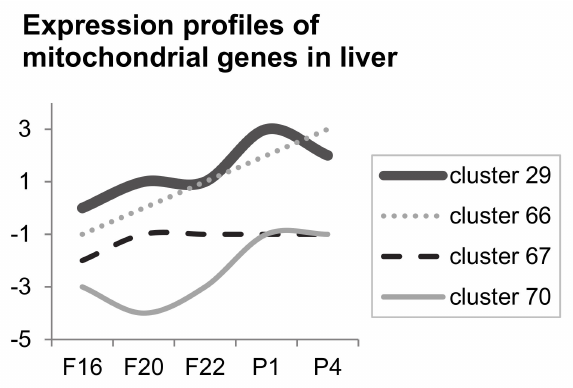
Figure 6. Four types of expression profiles significantly enriched in the rat liver (164 mitochondrial genes). A total of 1546 mitochondrial genes were analysed in STEM. Among 81 possible clusters, clusters named 29, 66, 67 and 70 were found to be significantly enriched in the liver (total 164 genes correlated with these four expression profile types—for gene table, see Table S1). No such enriched clusters were found in skeletal muscle, although GO “mitochondrion” GO:0005739 was found to be significant in both tissues per se. Analysis was performed in STEM